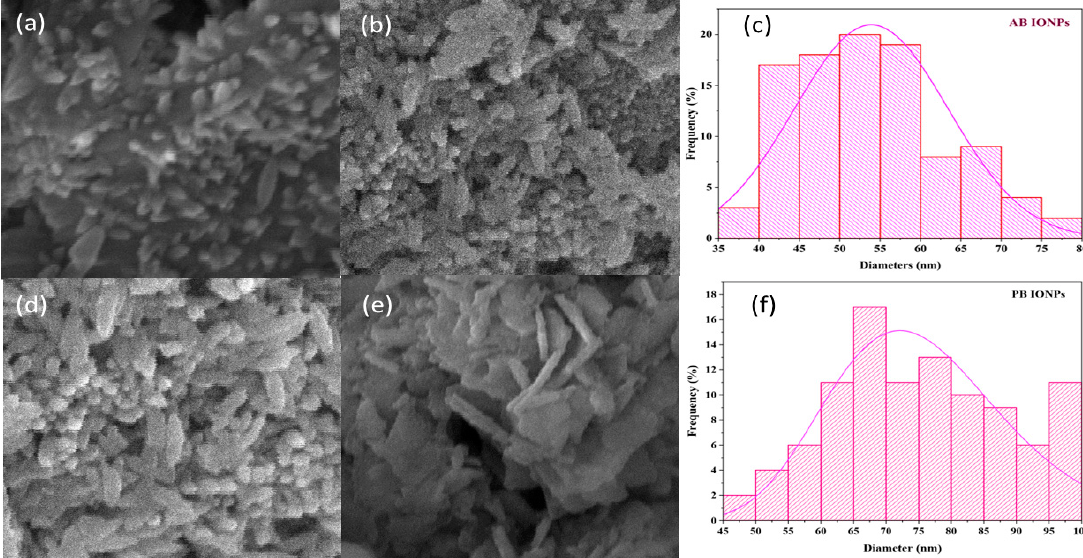
Figure 4. ( a ) SEM image of AB Fe 3 O 4 low-resolution NPs ( b ). AB Fe 3 O 4 NPs at high resolution ( c ). Size distribution histogram for AB Fe 3 O 4 NPs ( d ) SEM image of PB Fe 3 O 4 NPs at low resolution ( e ) PB Fe 3 O 4 NPs at high resolution ( f ). Size distribution histogram for PB Fe 3 O 4 NPs (Image J and Origin software were used to determine the particle size by selecting one hundred